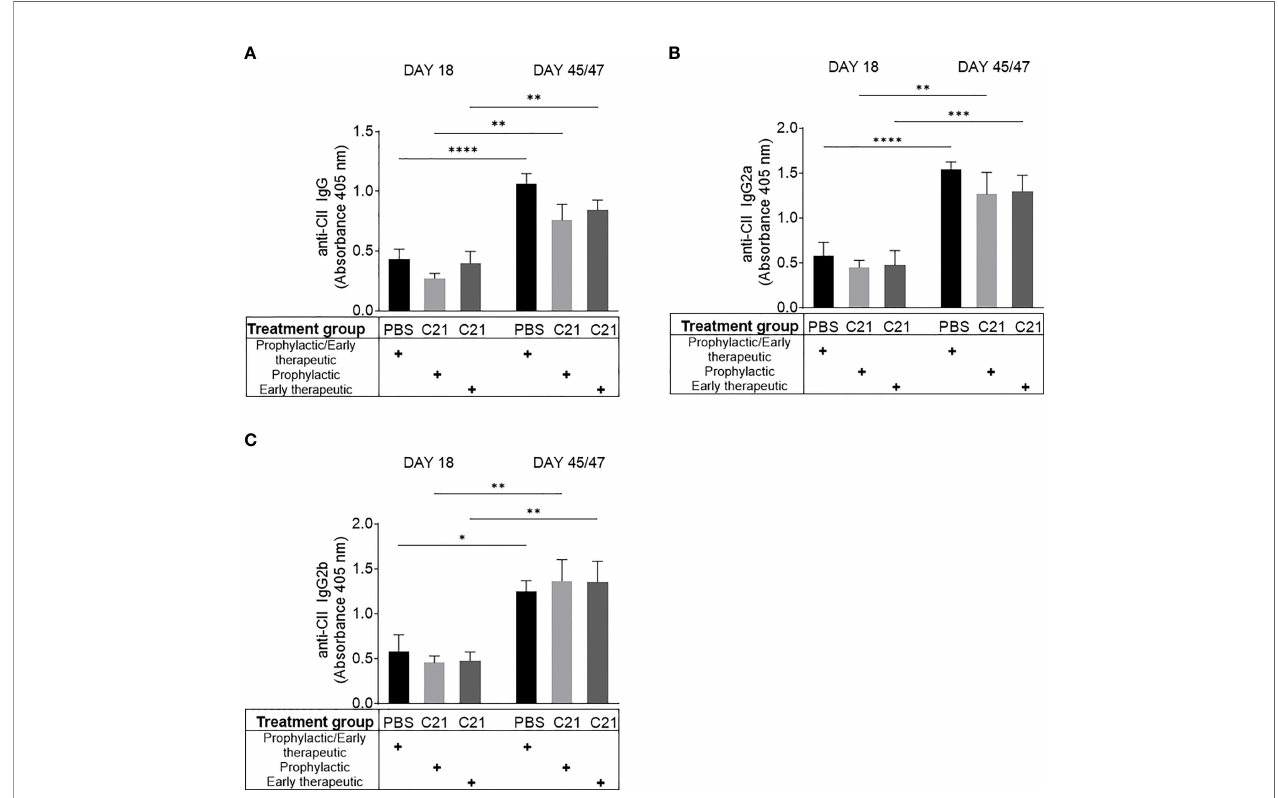
FIGURE 3 | AT 2 R stimulation did not alter antibody production against collagen type II (CII). Sera were collected within the prophylactic and the early therapeutic intervention trial at two time points (day 18 and day45/47 after CII immunization). Circulating anti-CII-IgG (A) , anti-CII IgG2a (B) and anti-CII IgG2b (C) antibodies were determined by ELISA and absorbances at 405nm are shown. PBS (n=10) [black bars], prophylactic C21 treatment (n=9) [light grey bars], early therapeutic C21 intervention (n=10) [dark grey bars]. P*<0.05, P**<0.01, P***<0.001, P****<0.0001. Values shown are the mean ± SEM. P-values were calculated using two-way ANOVA with Bonferroni ’ s